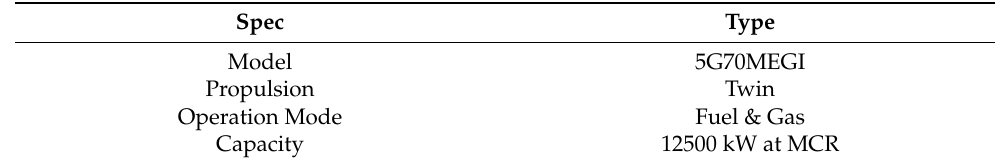
Figure 3. Specific fuel oil consumption and gas emission. Table 1. 173 K LNG Carrier engine specification.